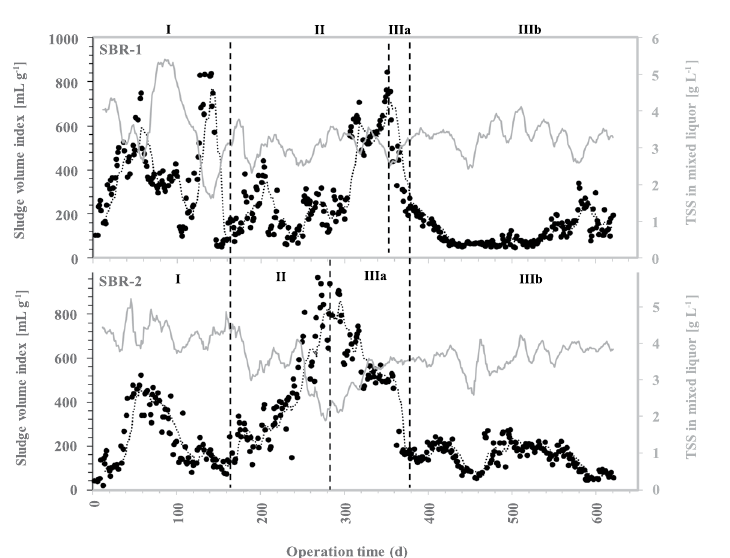
Figure 2. Sludge volume index (SVI, • ) profile and TSS in mixed liquor (grey lines) of SBR1 (top) and SBR2 (bottom) over the experimental period. Mitigation strategies consisted of the addition of polyaluminium chloride (I), inhibition of VFA production (II) and modification of the feeding pattern with (IIIa) or without (IIIb) aeration in the buffer tanks. SVI values were measured after 30 min settling. Day 1 corresponds to January 1 st ,